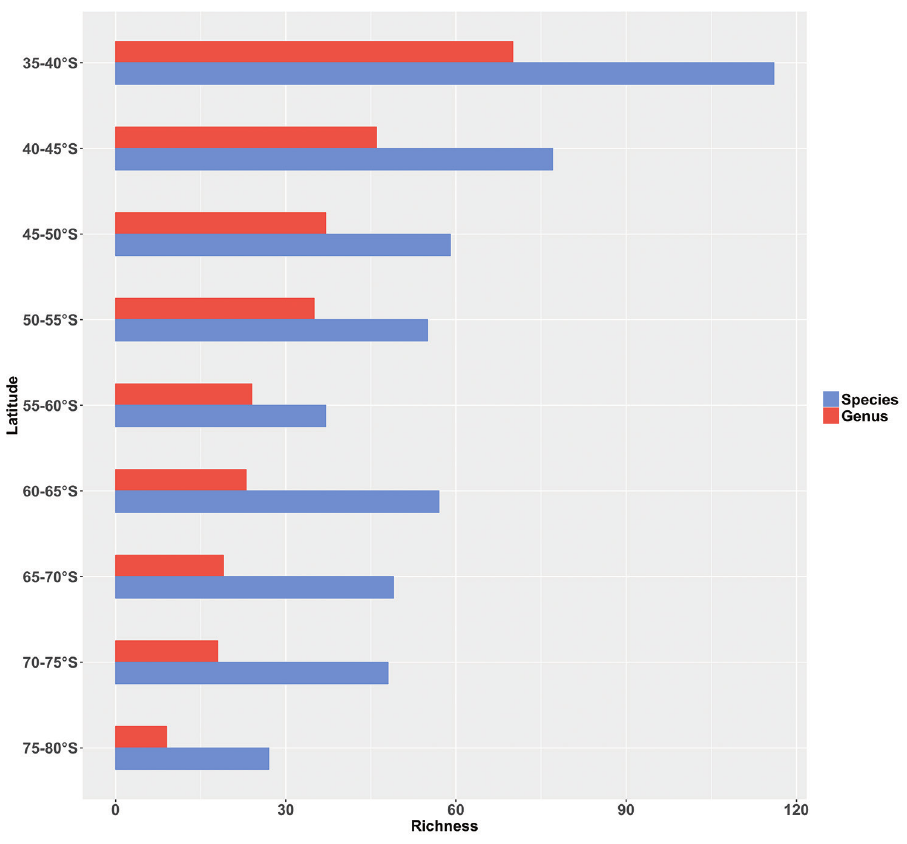
Figure 5. Species (blue) and genus (red) richness against